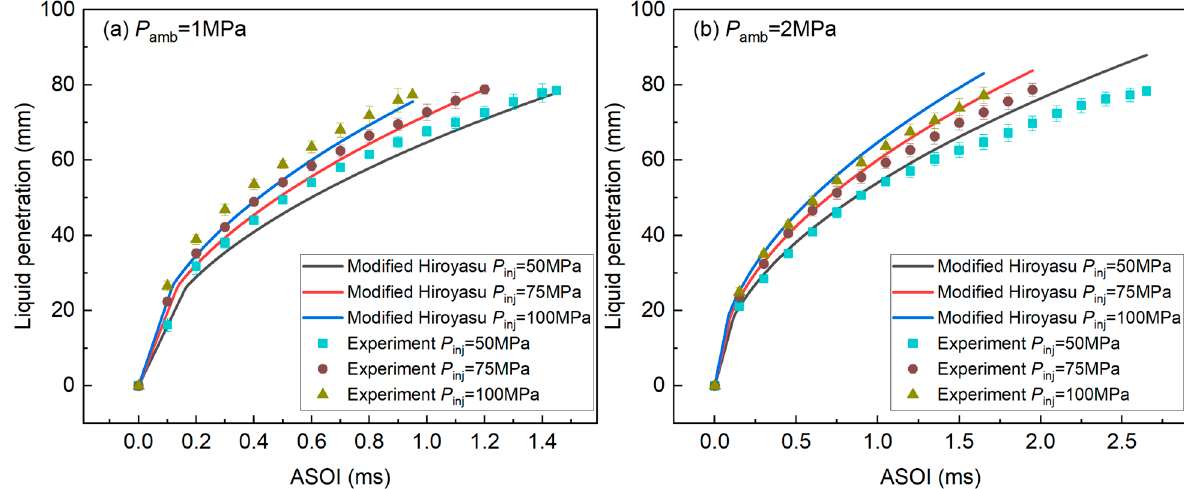
Figure 6. Model predictions of the modified Hiroyasu model; (a) P amb = 1 MPa, (b) P amb = 2 MPa.